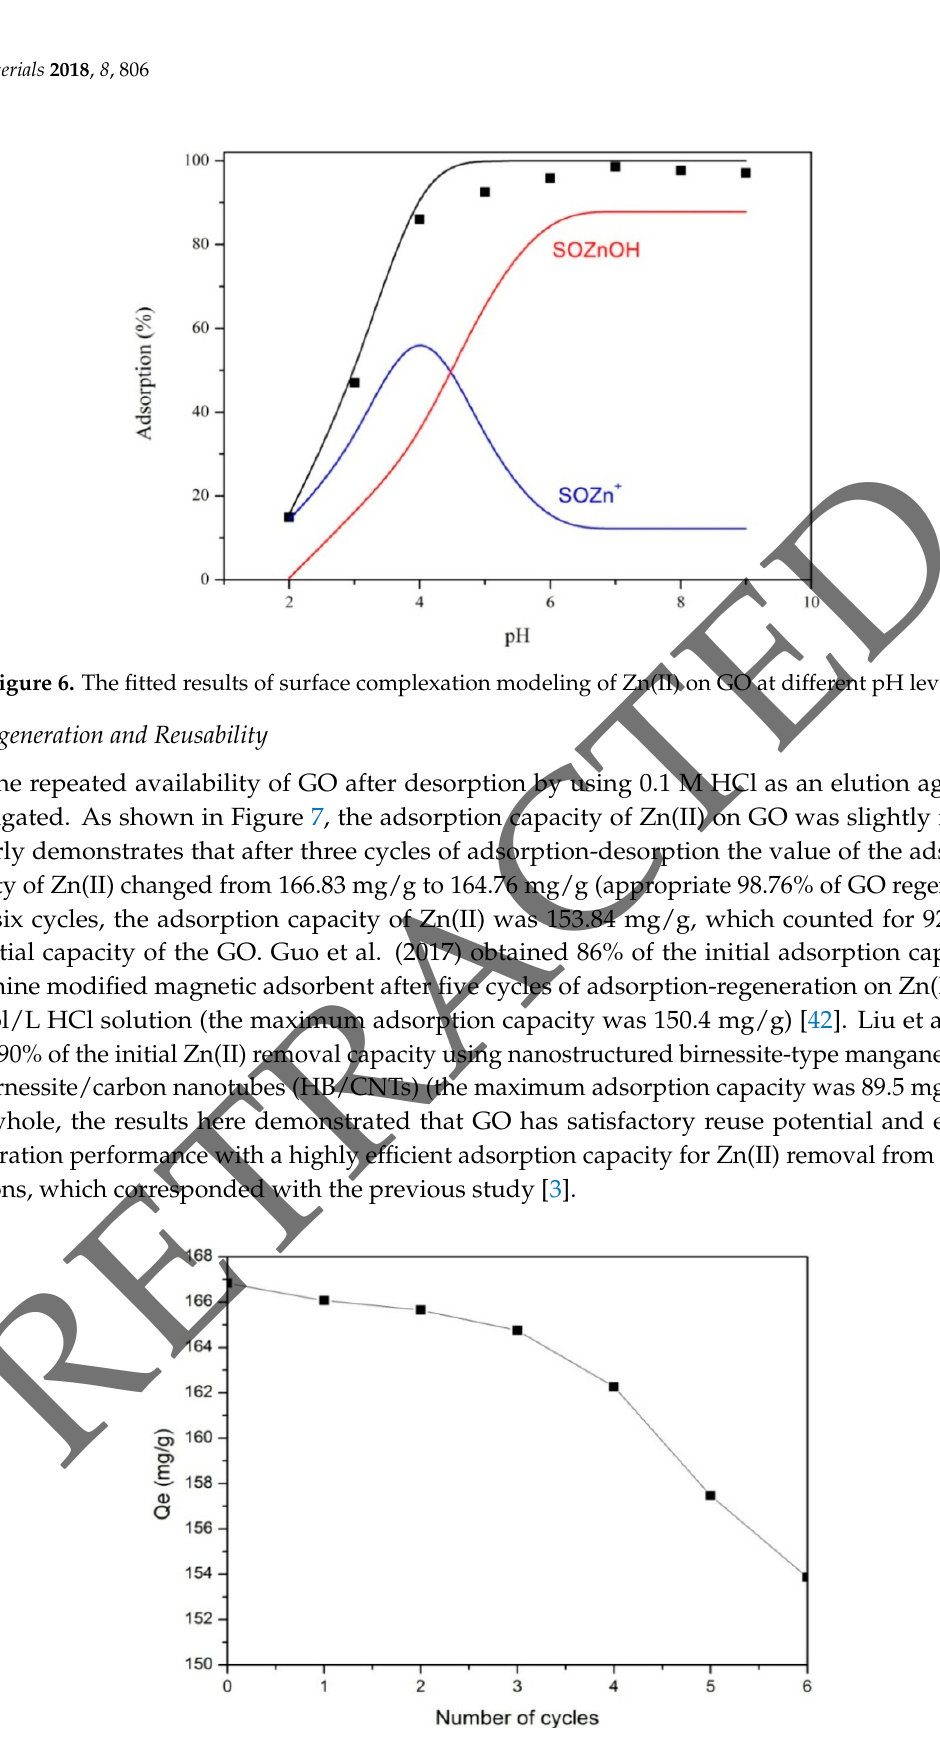
Figure 7. Adsorption-desorption cycles of Zn(II) on GO nanosheets ( C 0 = 10 mg/L, m/v = 0.12 g/L, I = 0.01 mol/L NaClO 4 , T = 293 K).